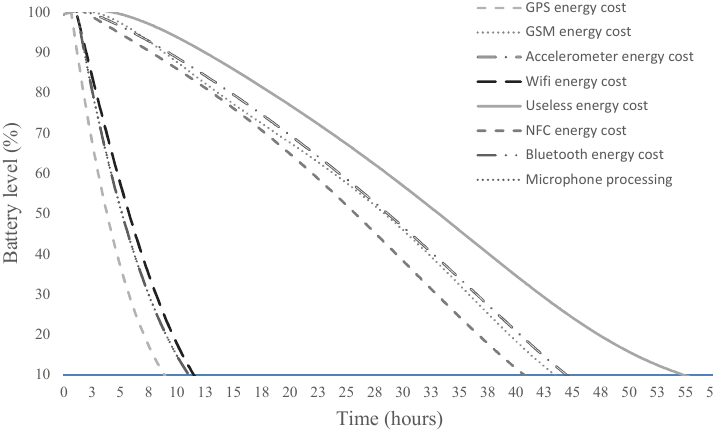
Figure 2. Energy cost comparison between sensors embedded in